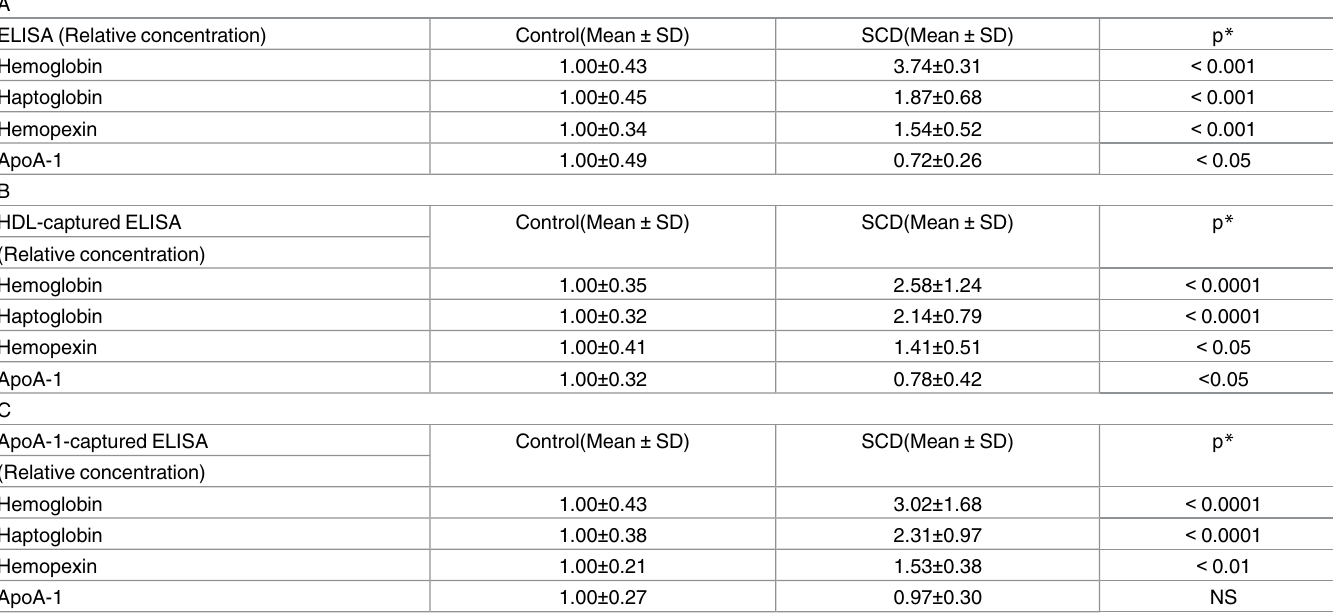
Table 3. Levels of hemoglobin (Hb), haptoglobin (Hp) and hemopexin (Hx) associated with HDL in 32 sickle cell disease (SCD) patients and 28 healthy normal donors